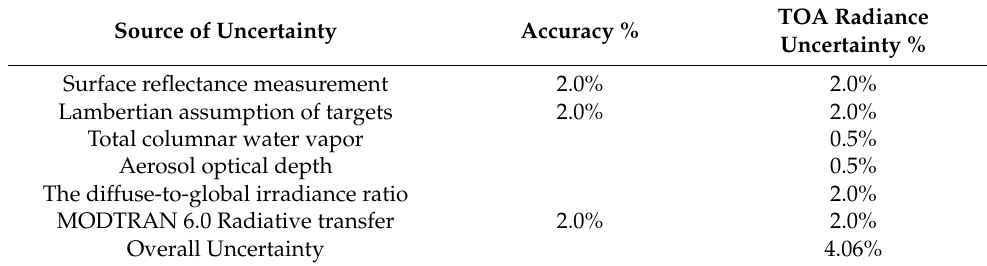
Table 7. Sources of uncertainties in TOA radiance in the irradiance-based method. TOA Radiance Source of Uncertainty Accuracy % Uncertainty % Surface reflectance measurement 2.0% 2.0% Lambertian assumption of targets 2.0% 2.0% Total columnar water vapor 0.5% Aerosol optical depth 0.5% The diffuse-to-global irradiance ratio 2.0% MODTRAN 6.0 Radiative transfer 2.0% 2.0% Overall Uncertainty